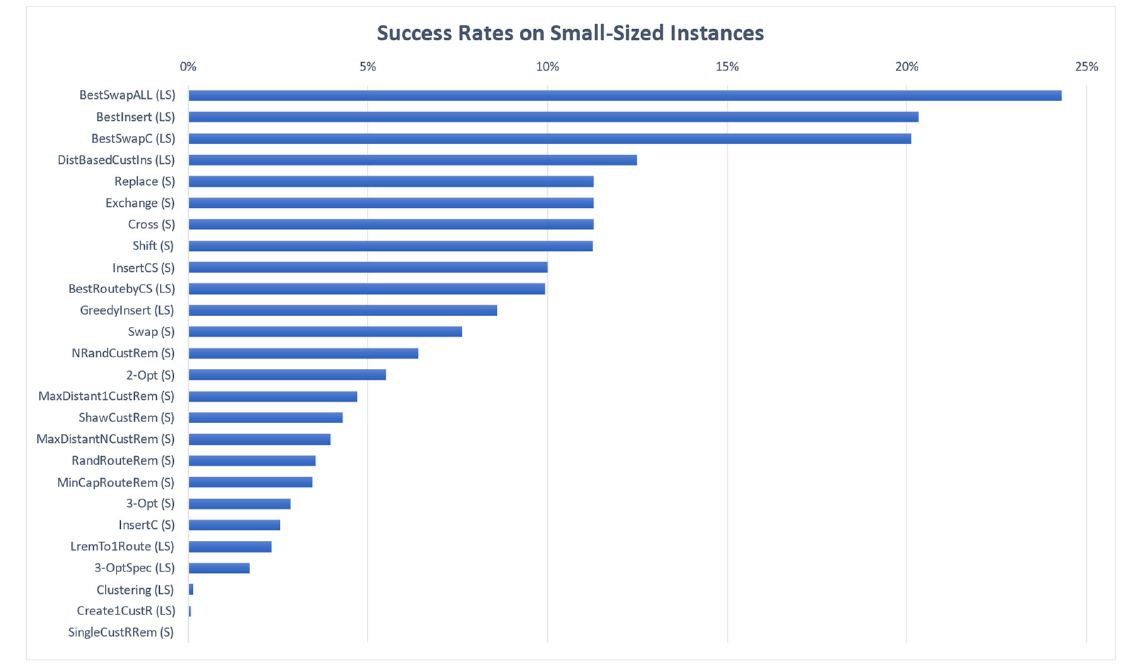
Figure 2. Most-successful operators in shaking and local search steps in small-sized instances .